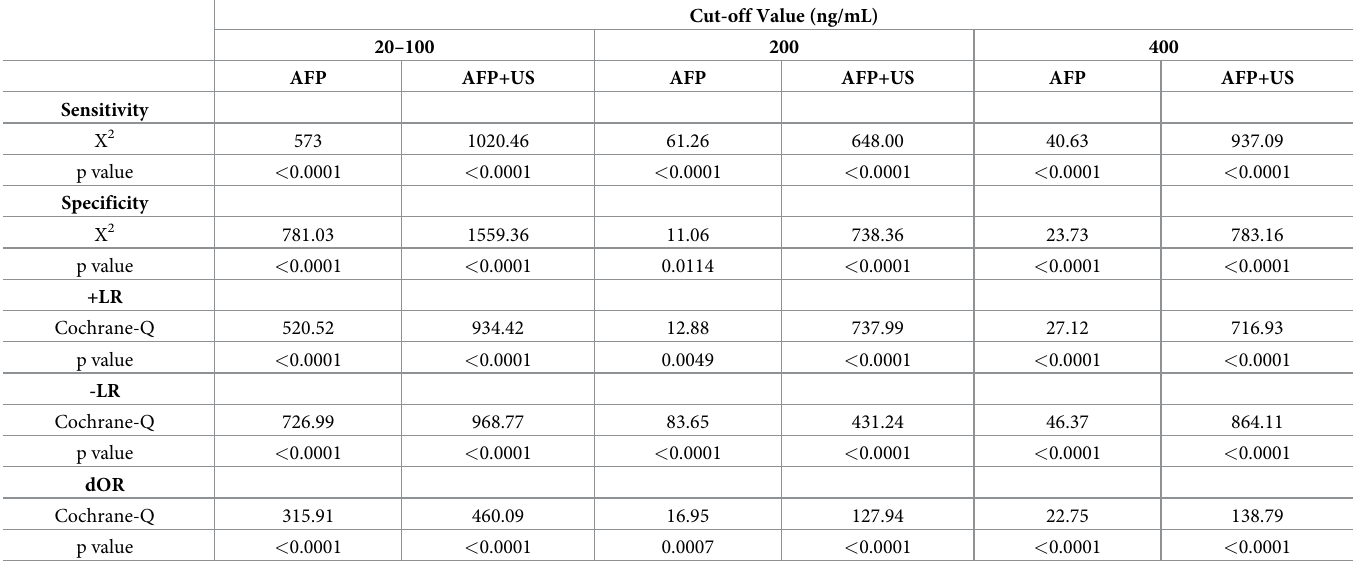
Table 5. Chi-square test and Cochrane-Q test results.